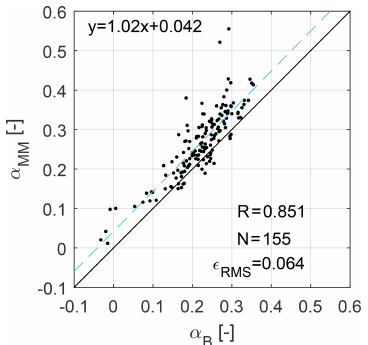
Figure 8. Correlation between the lower-half-rotor vertical shear α lower , B and the met-mast shear (up to hub height) α MM , for wind directions from 190 to 200 ◦ .